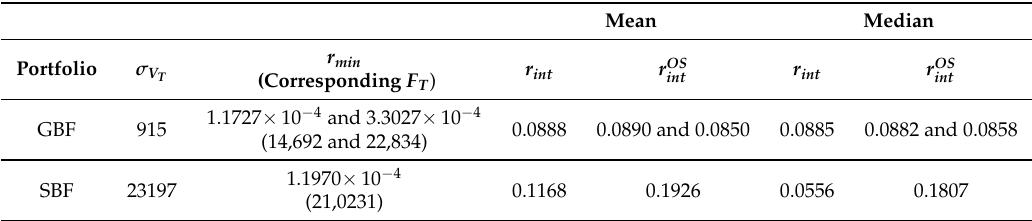
Table 2. Internal return of Domestic Government Based Fund(GBF), Stock Based Fund(SBF) and Equivalent Optimal Strategy (OS) based on mean and median value of the pension funds at maturity (fixed r min and σ = 0.025).